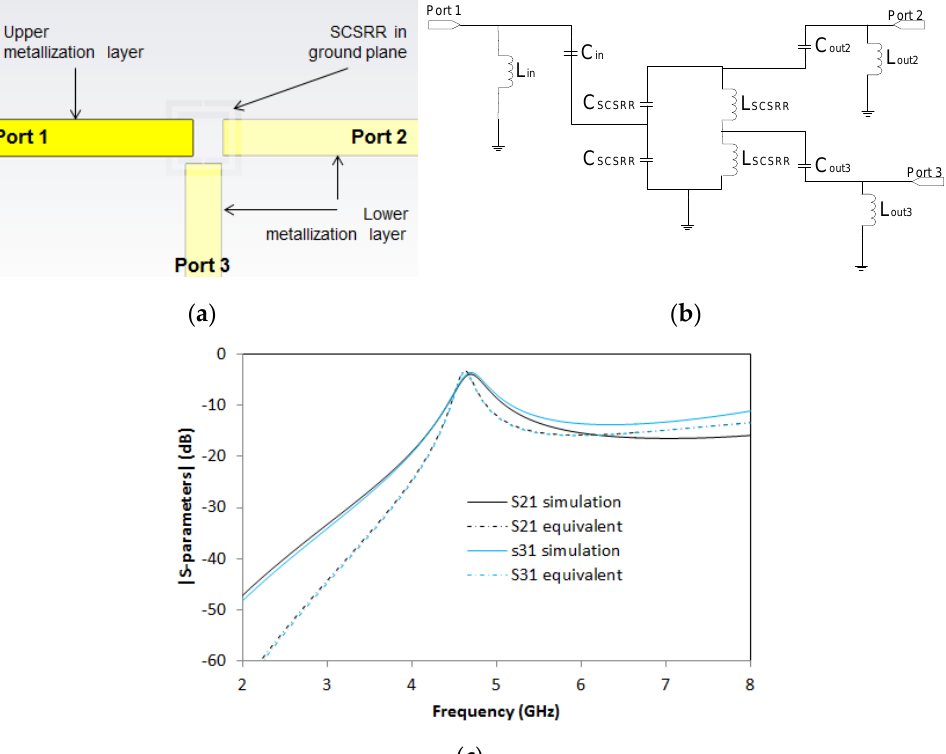
Figure 16. ( a ) Top view layer distribution 2-layer power divider, with two outputs in second layer. ( b ) Equivalent circuit model 2-layer power divider. ( c ) Simulated S21 (solid black line) and simulated S31 (solid blue line). Equivalent circuit S21 (dashed-dotted black line) and equivalent circuit S31 (dashed-dotted blue line).